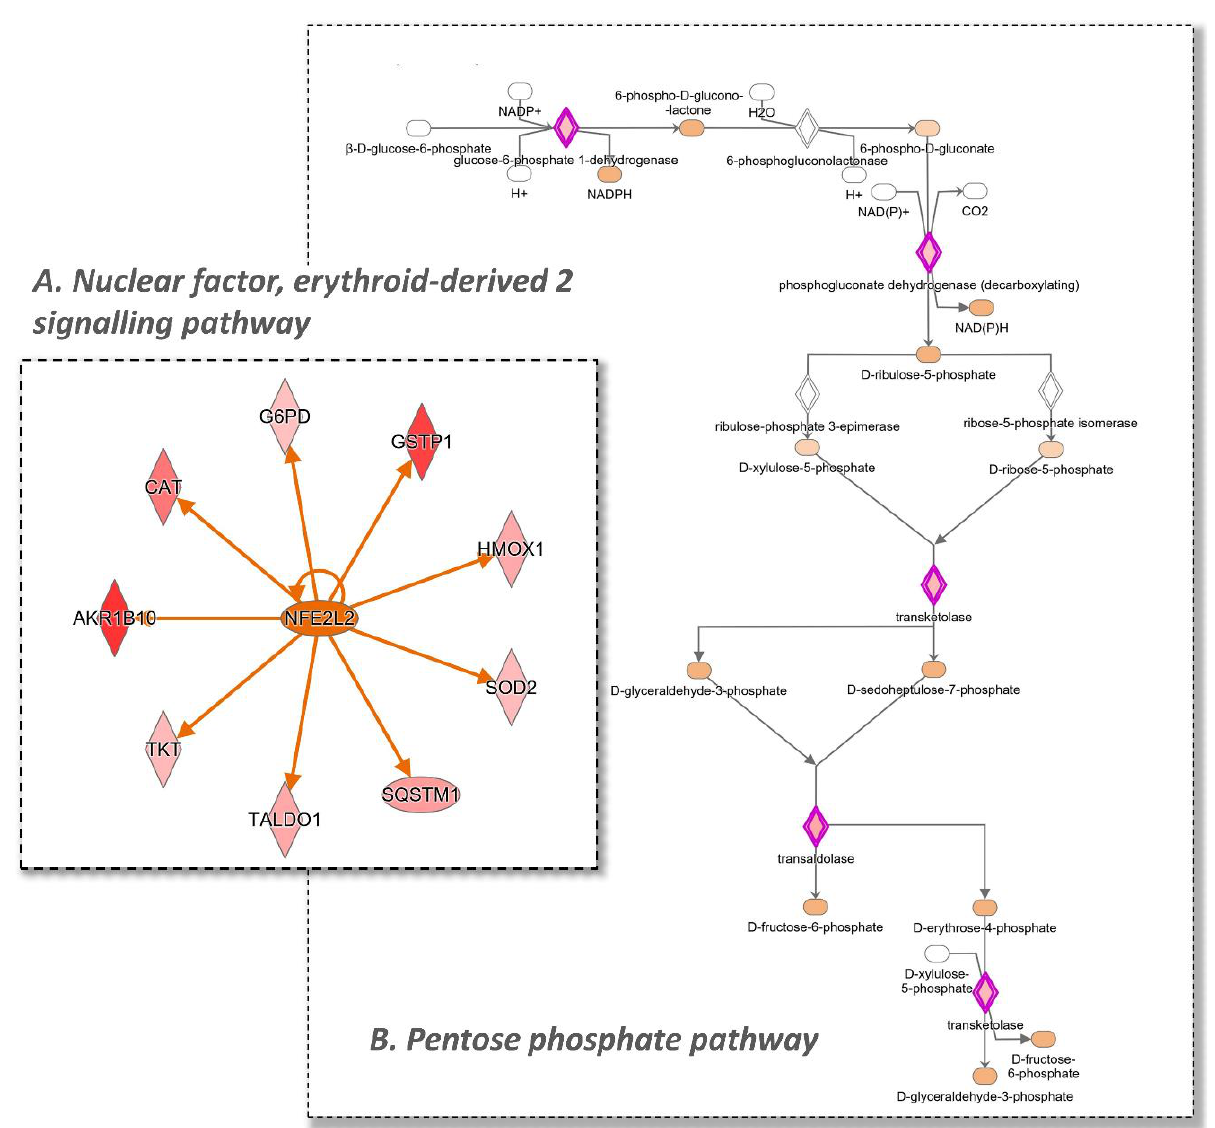
Figure 6. IPA analysis of the effect of the extract on the cell proteome. ( A ) illustrates that the differentially regulated proteins in the analysis are consistent with an NRF2 activation. ( B ) illustrates the Pentose Phosphate Pathway; in red are the proteins that were found to be up-regulated by TAP, resulting in a increment in the NADPH pool in the cell. Color legend: red represents the increased genes, green the decreased (not present in the figure). The intensity of the color is related to the intensity of up- or down-regulation. The orange line leads to activation and a blue line (not present in the figure) leads to inactivation. The yellow line indicates that findings that are not consistent with the proteomics results obtained.